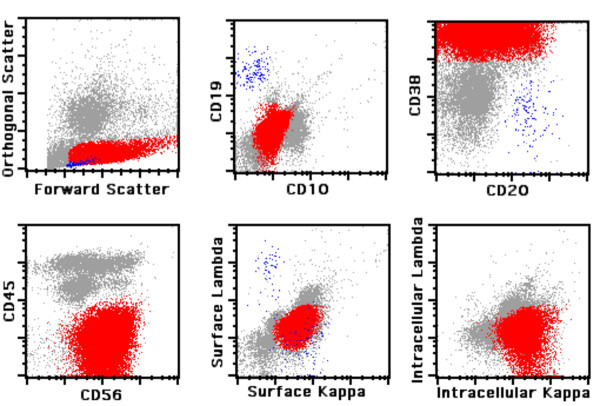
Flow cytometric analysis of plasma cell myeloma. Mature B lymphocytes are painted in blue and neoplastic plasma cells in red.